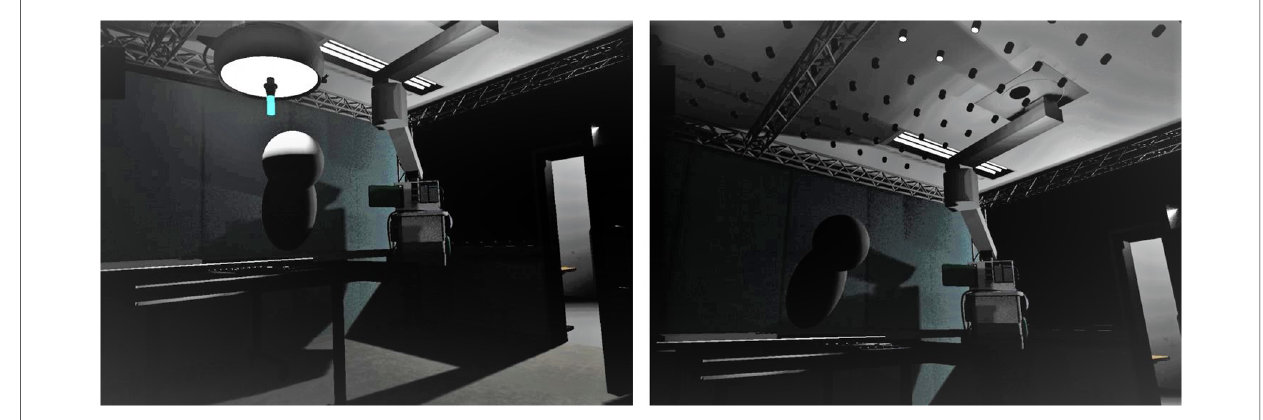
FIGURE 1 The VR-environment showing a dark OR-like room with only the table illuminated by the SLS. Once light from the SLS is blocked from reaching the table, e.g., by the occluder in the centre above the table, the working area appears dark and light needs to be re-adjusted by grabbing the green handle of the